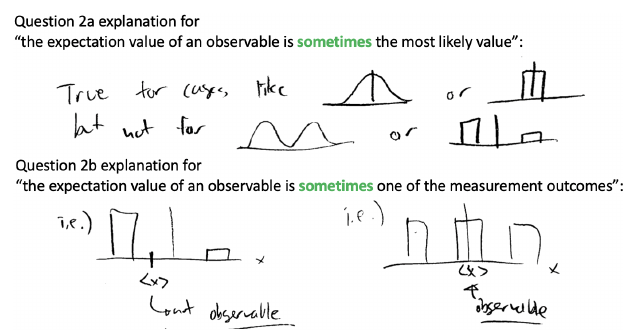
FIG. 3. Student explanations for their responses on questions 2a and 2b. Student is from class